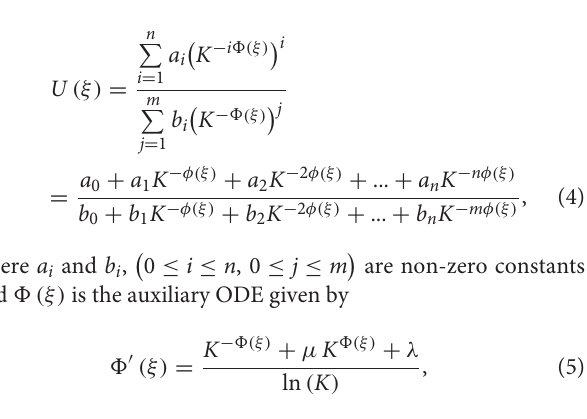
FIGURE 9 | 2-D, 3-D, and contour plot of Equation (29), when t γ 0.2, α 0.5, β 0.6 and z = = =